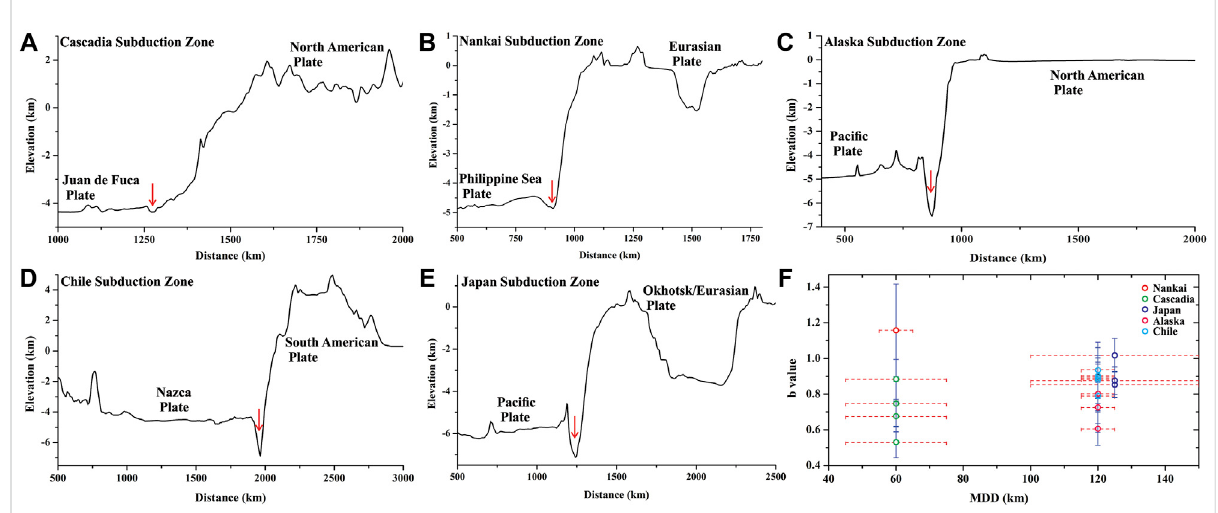
FIGURE 10 (A – E) Trenchnormaltopographicpro fi lesoftheCascadia,Nankai,Alaska,Chile,andJapansubductionzoneswithincreasingtrenchdepths. (F) Plots of the b-values of overriding plate earthquakes in selected natural subduction zones and their corresponding MDD